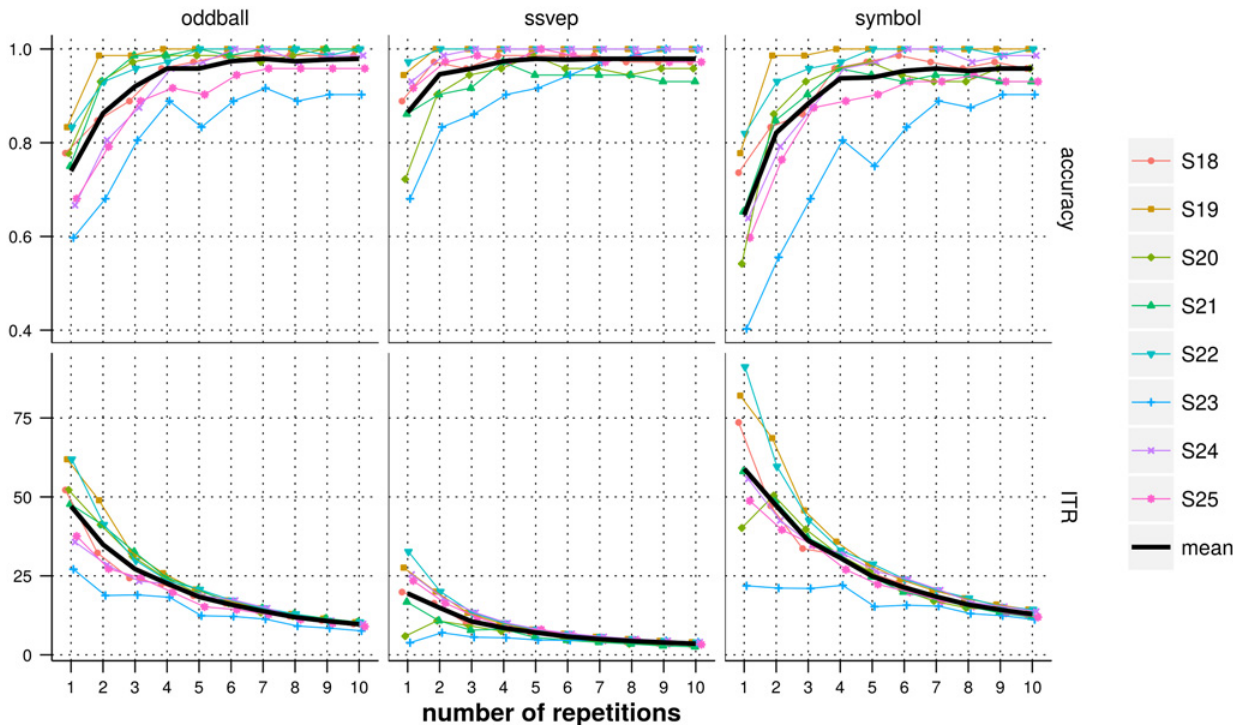
Fig 9. Detection accuracies (top) and ITR values (bottom) with respect to the number of repetitions considered for each subject for the ERP (left), SSVEP frequency (middle) and target icon (left). The black lines represent the average over all subjects. One repetition of the stimulation cycle lasted for 1.5s, the stimulation duration for a number n r of repetitions is thus 1.5× n r